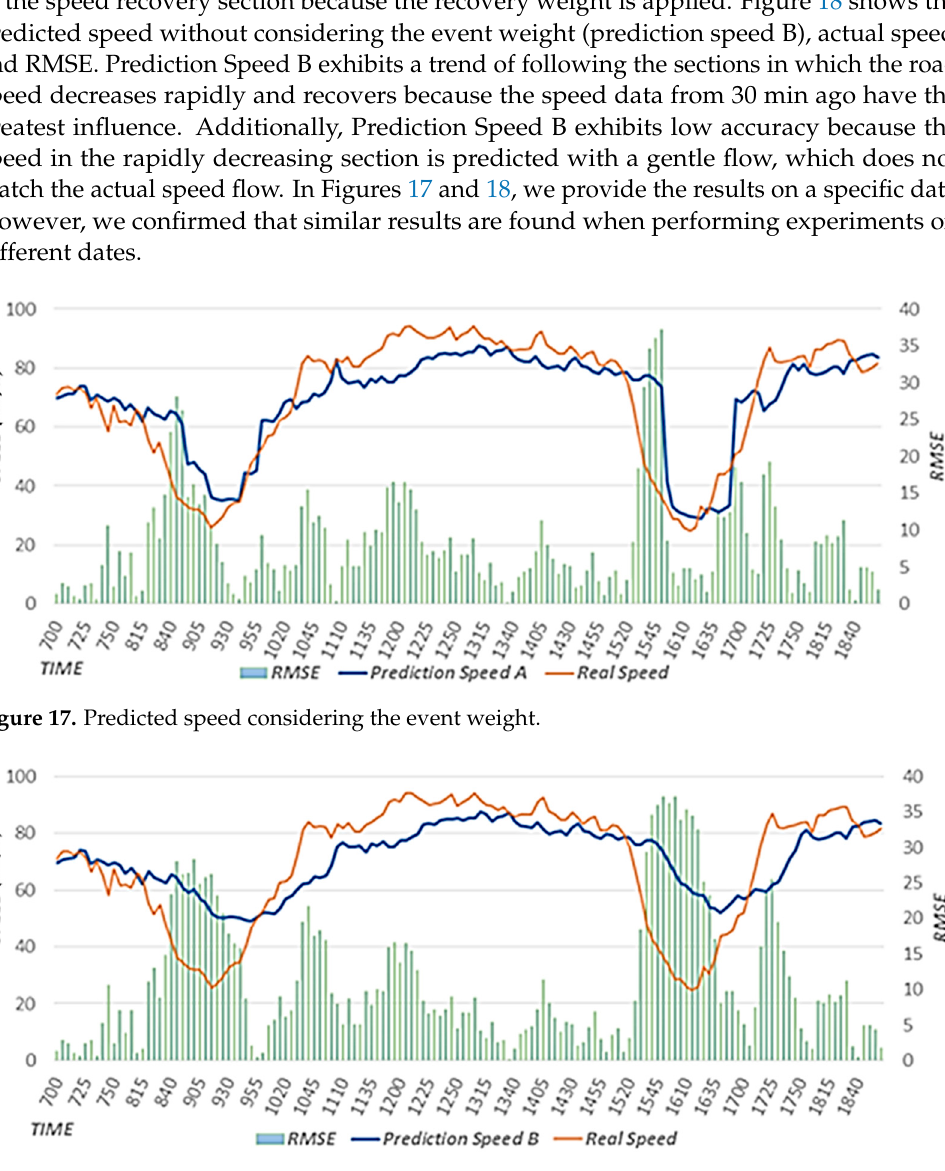
Figure 18. Predicted speed without considering the event weight.